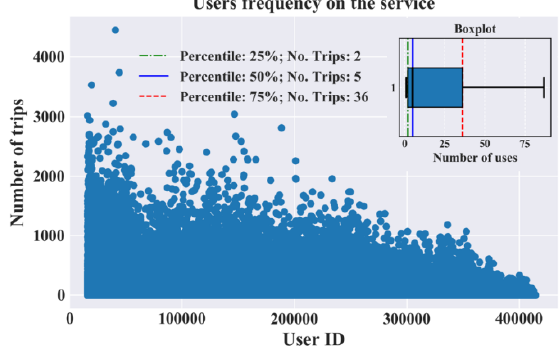
Figure 4. Frequency of use of the service per